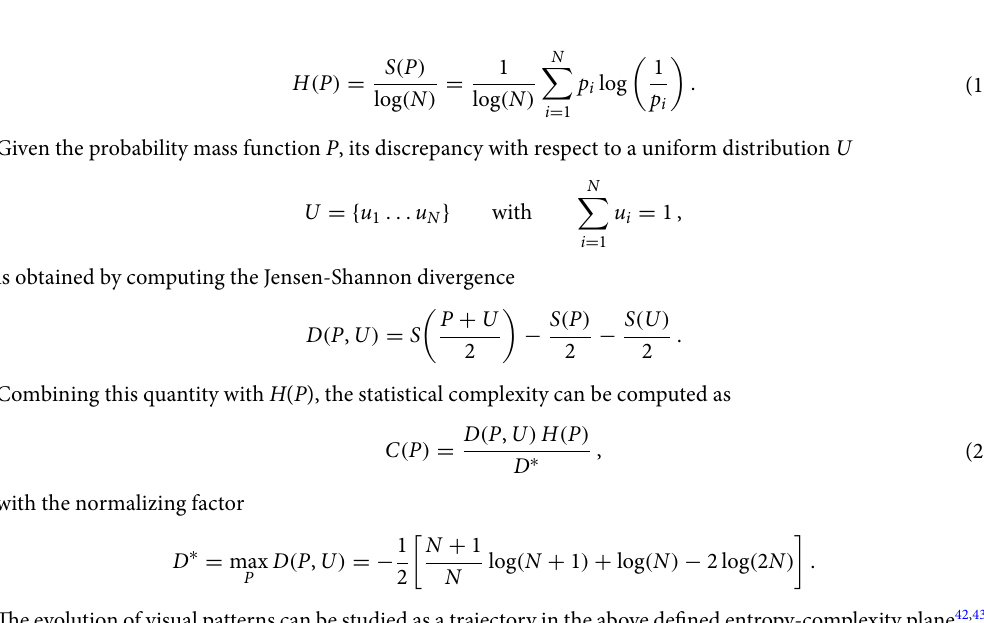
Figure 5. Panel ( a ): joint distribution of average-pairwise distance S and cluster size. Each dot corresponds to a cluster, i.e. a template for memes. Red dots represent “noisy clusters” identified by HDBSCAN that are outliers with respect to the cluster size and S k distributions, shown respectively in panels ( b ) and ( c ). Noisy clusters are removed from the